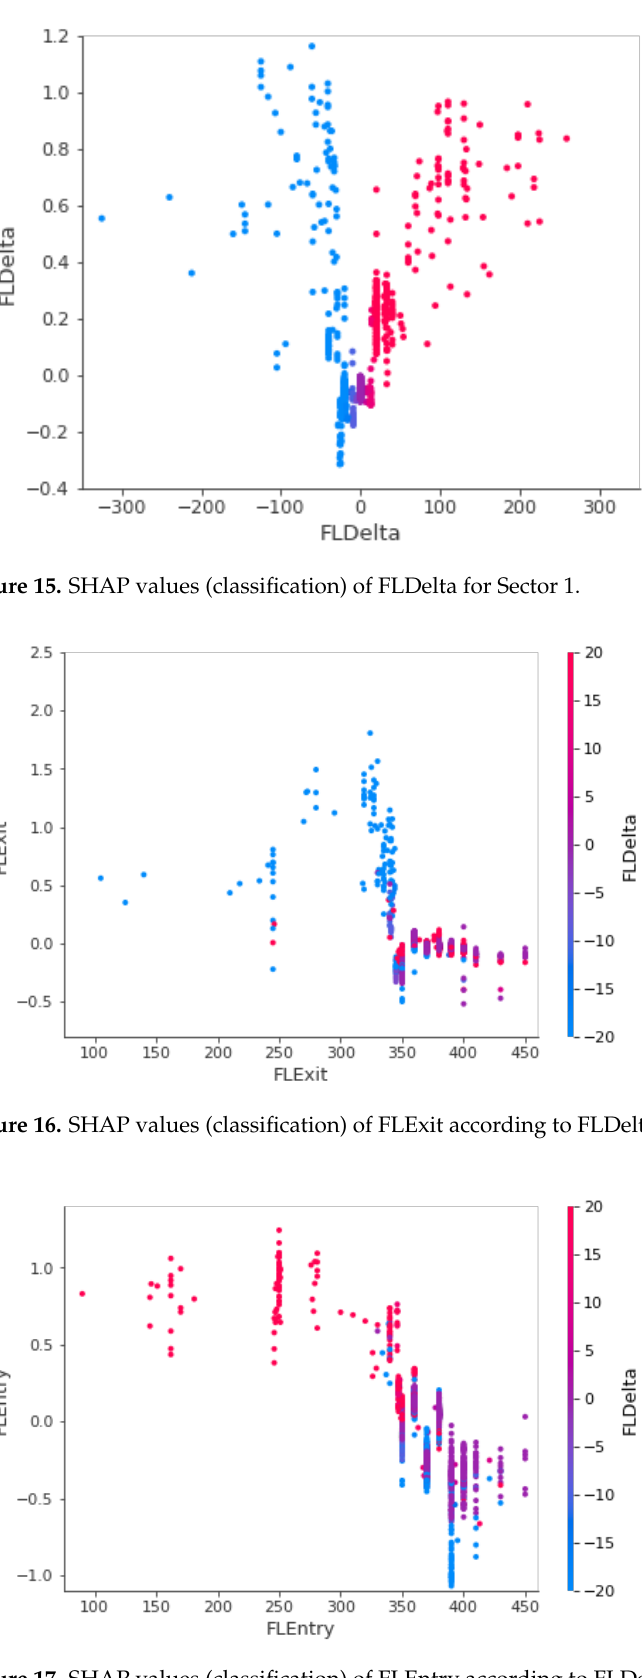
Figure 17. SHAP values (classification) of FLEntry according to FLDelta for Sector